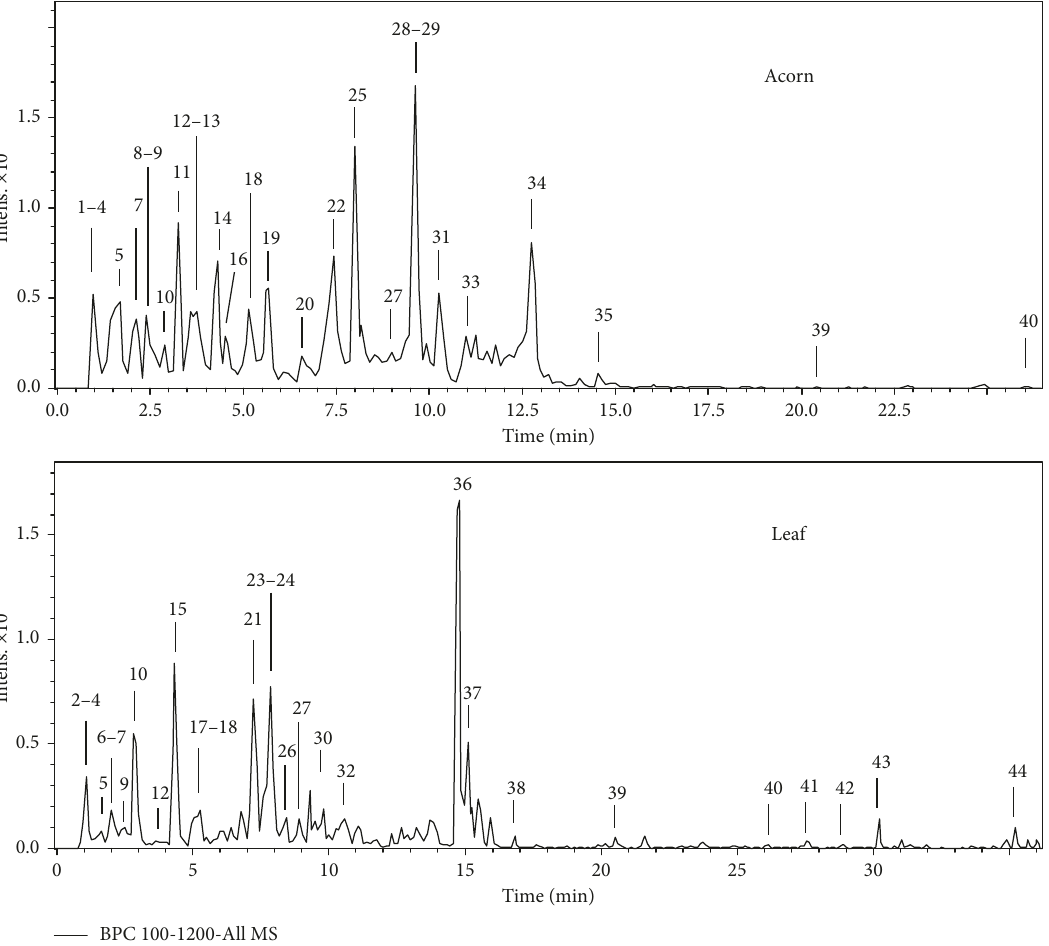
Figure 1: HPLC-ESI/MS n base peak chromatograms (BPCs) of the methanolic extracts of acorns and leaves of Q. coccifera